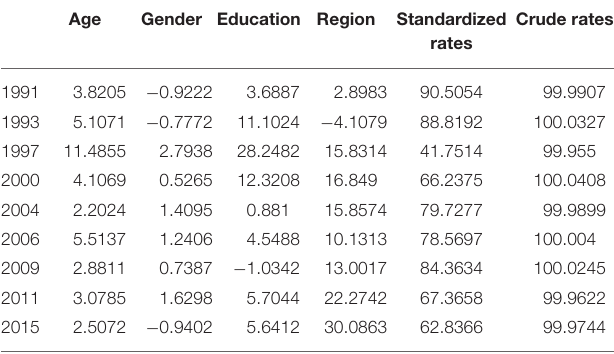
TABLE 2 | Contributions (%) of each factor in HTN rates of older adults by decomposition, 1991–2015. Age Gender Education Region Standardized